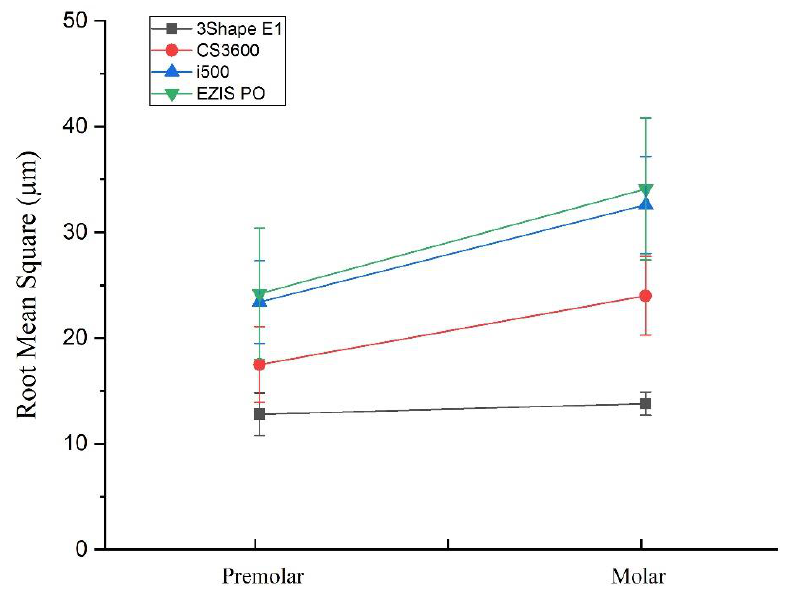
Figure 5. Comparison of RMS values for premolars and molars according to scanner.